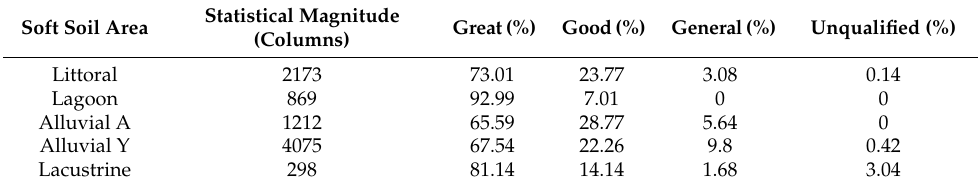
Table 7. The proportions of quality level of DSM columns in different soft soil areas.